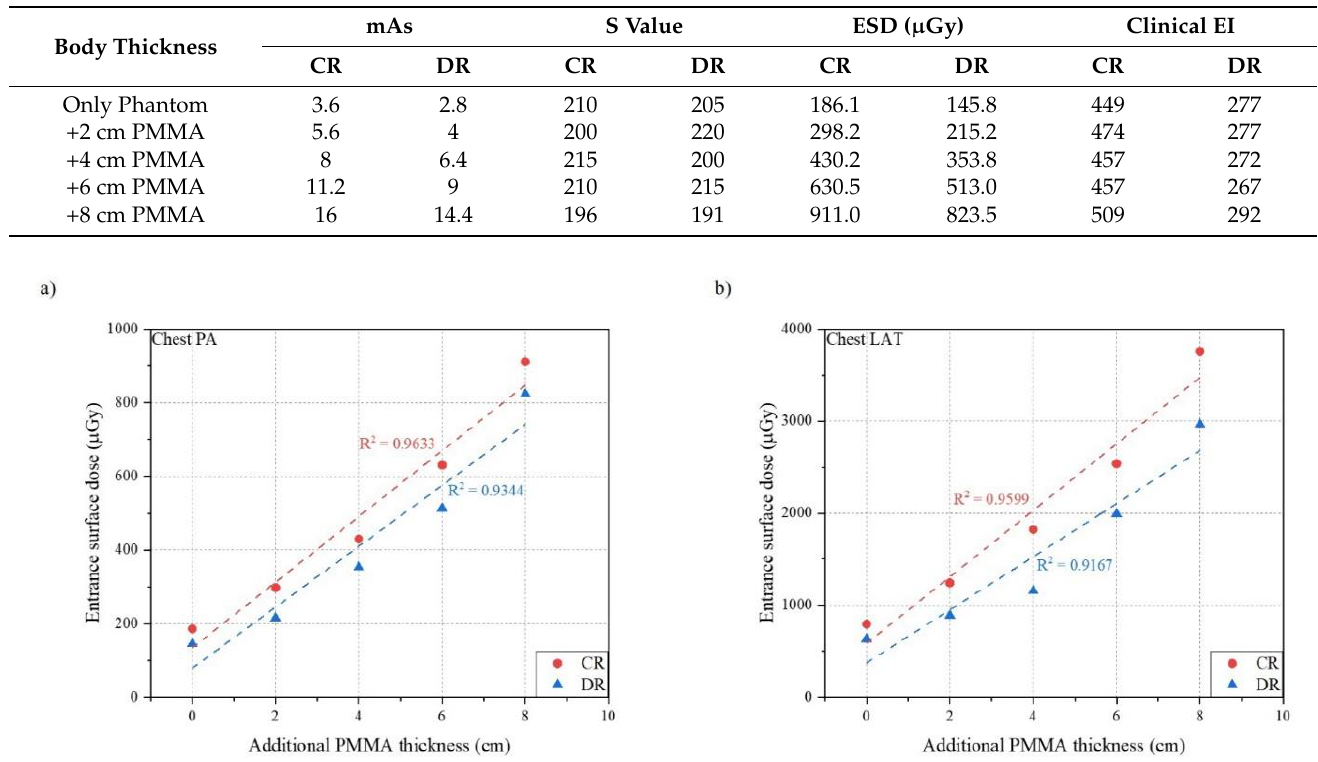
Figure 5. Relationship between phantom thickness and entrance surface dose: ( a ) Chest PA; ( b ) Chest LAT.